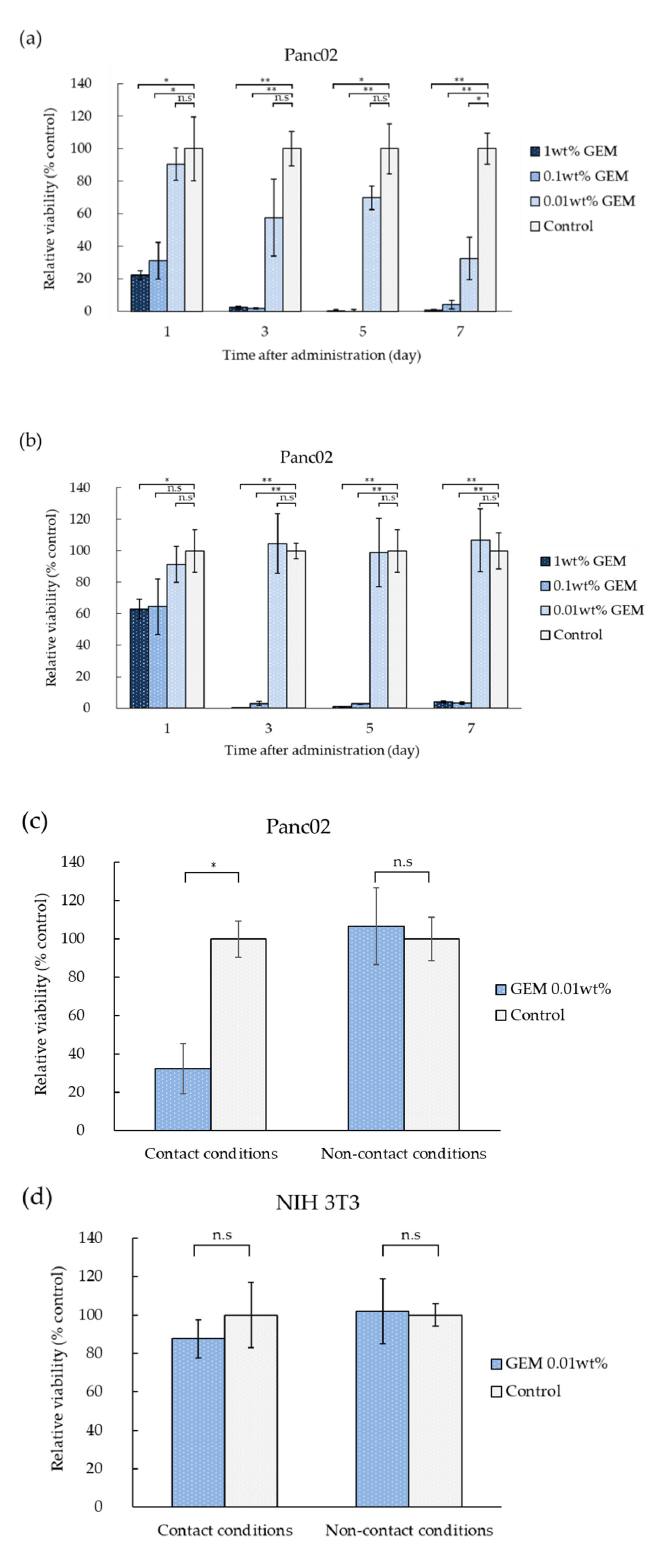
Figure 3. Cytotoxic effects of the non-woven sheets on the murine pancreatic cancer cell line (Panc02) and NIH-3T3 cells. ( a ) Relative cell viability in the treatment group over time (compared with the control group [GEM-free non-woven sheet]). Cell viability on days 1, 3, 5, and 7, respectively, was 22.3 ± 2.8%, 2.3 ± 0.9%, 0.05 ± 0.9%, and 0.6 ± 0.6% in the presence of 1 wt% GEM; 31.1 ± 9.9%, 1.8 ± 0.3%, − 5.0 ± 5.8%, and 4.1 ± 2.6% in the presence of 0.1 wt% GEM; and 90.4 ± 9.9%, 57.7 ±